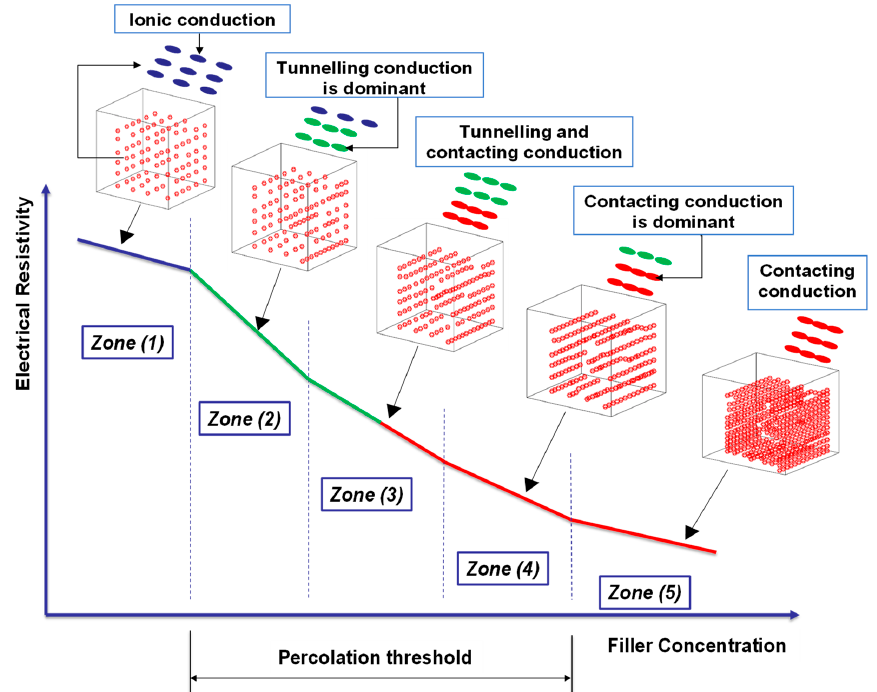
Figure 7. The relationship between the filler dosage and the electrical resistivity without externally applied loads. applied